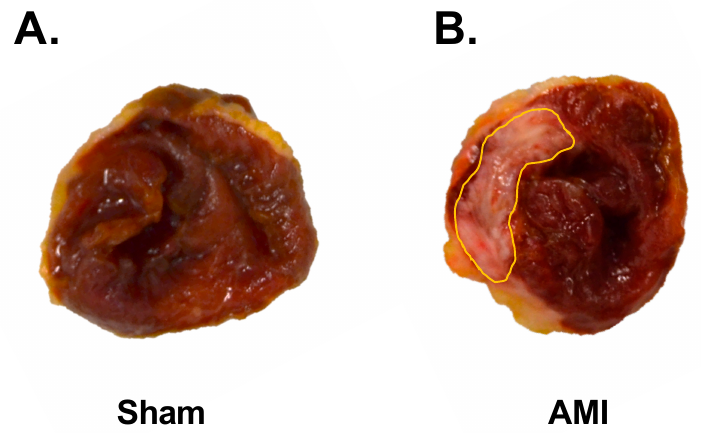
Figure 10. Infarcted area of one experimental case of AMI group ( B ) and an experimental case of the sham group ( A ) where no infarcted area is observed.